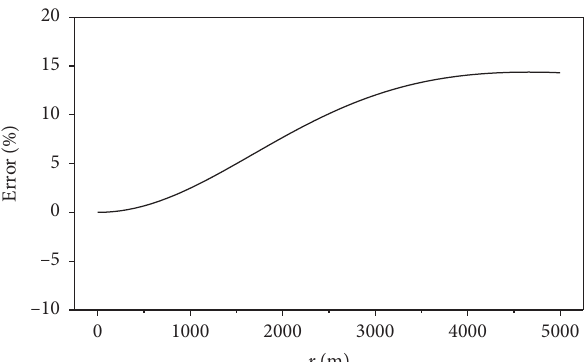
Figure 5: The relative error between approximate and accurate solutions while z � 0.